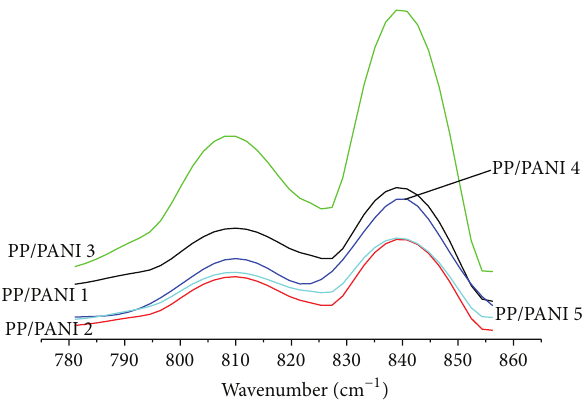
Figure 4: FTIR spectra of the PP/CPP/PANI composites with different CPP concentrations (780–856 cm −1 ).